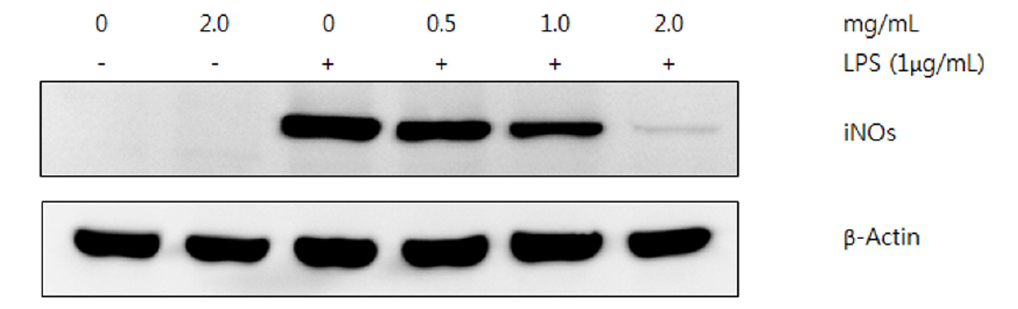
Figure 5. Inhibitory effect of acetone extract from fruiting bodies of Pleurotus florida on LPS-induced expression of iNOS protein. RAW 264.7 cells were incubated with LPS (1 µg) in the presence or absence of indicated concentration of mushroom. β -Actin was used as an internal